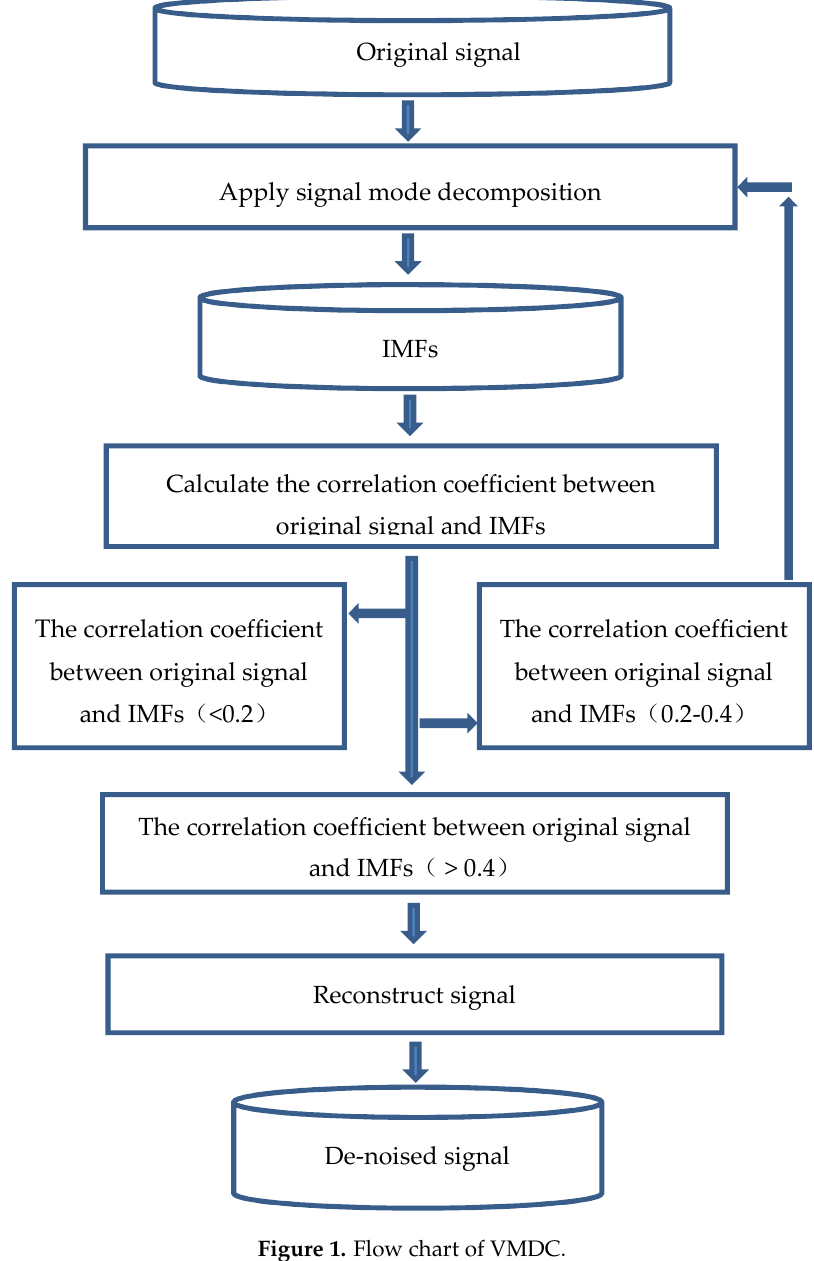
Figure 1. Flow chart of VMDC.